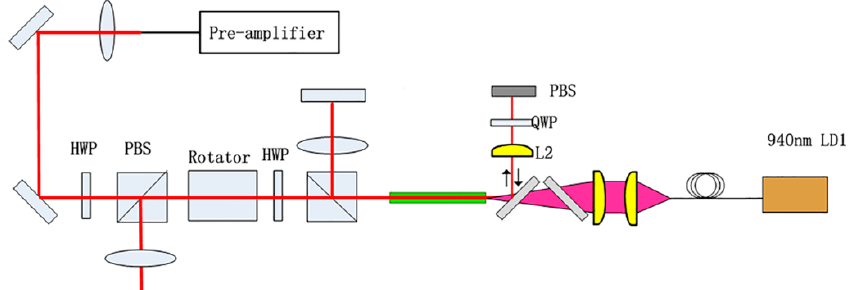
Figure 8. Polarization controlled four ‐ pass amplification.